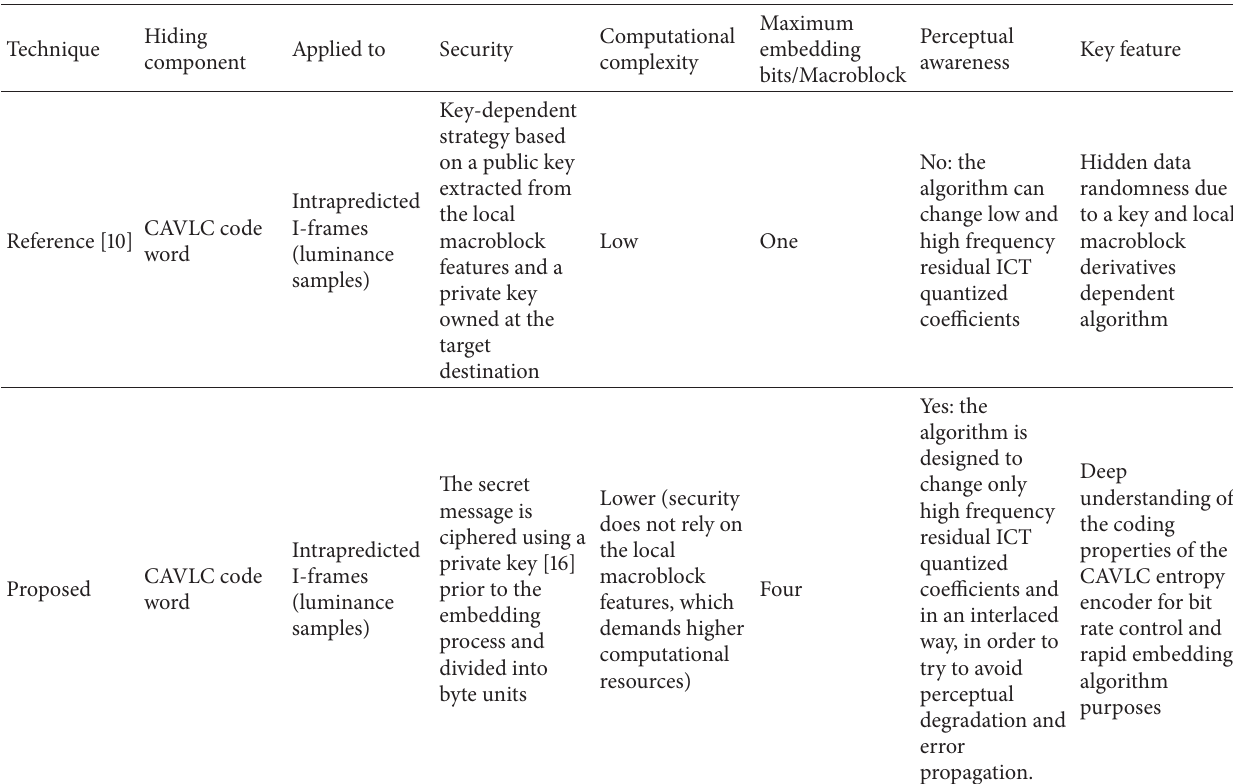
Table 1: Comparative table of the technique proposed and